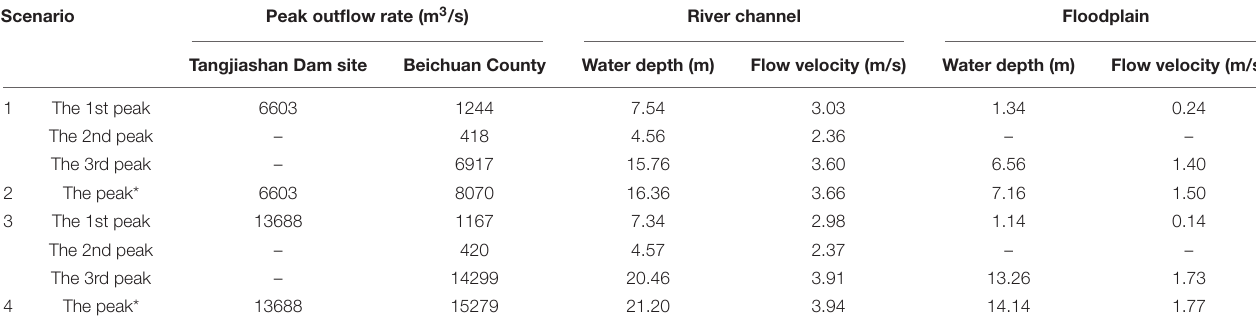
TABLE 3 | Hydraulic parameters of cascading breach in the four scenarios in Beichuan